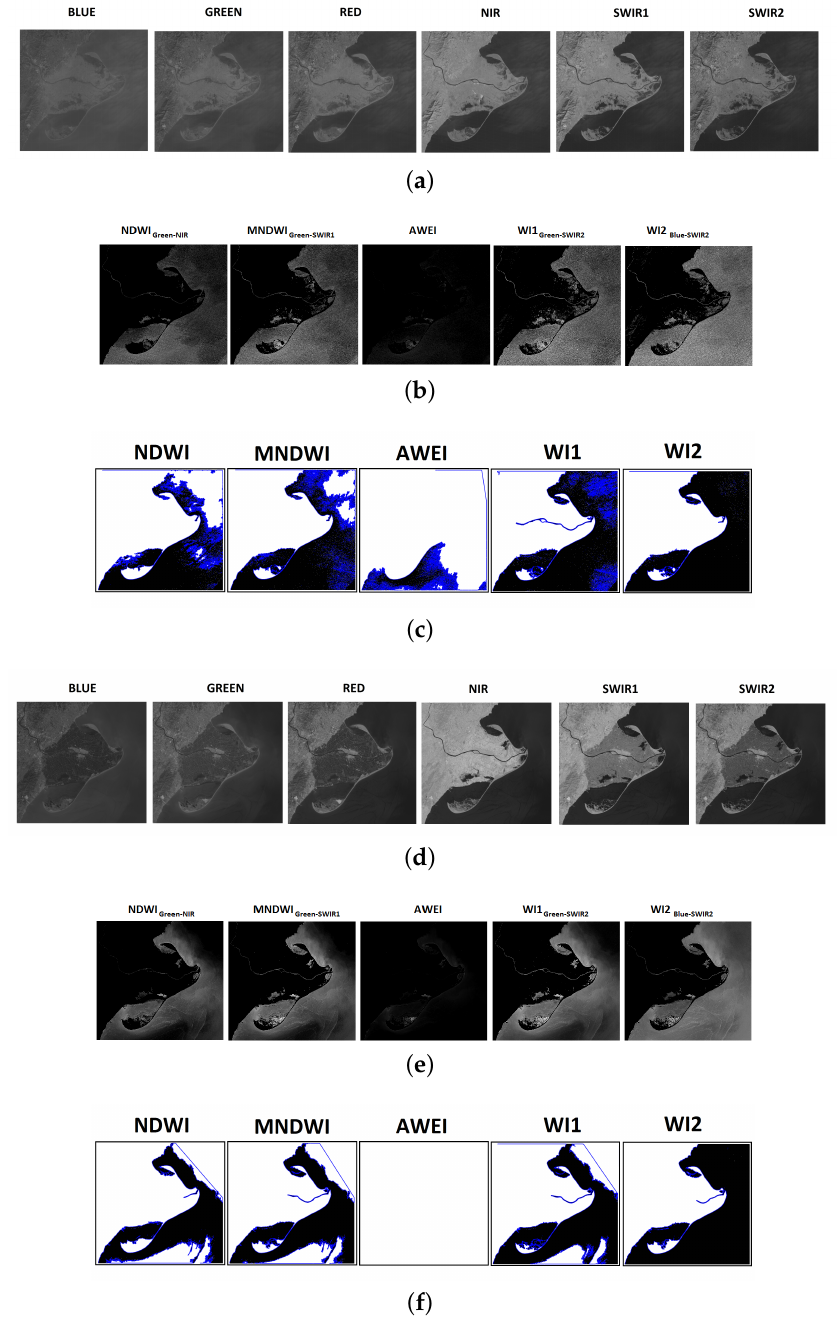
Figure 16. Errors detected after the methodology was applied to the set of 185 images in the Ebro River Delta. ( a ) The corrected Landsat band images from 30 January 2000. ( b ) The water indexes calculated from Landsat band images from 30 January 2000. ( c ) The coastline detected from water indexes calculated from a Landsat Image (30 January 2000). ( d ) The corrected Landsat image from 31 July 2014. ( e ) The water indexes calculated from Landsat band images from 31 July 2014. ( f ) The coastline detected from water indexes calculated from a Landsat Image (31 July